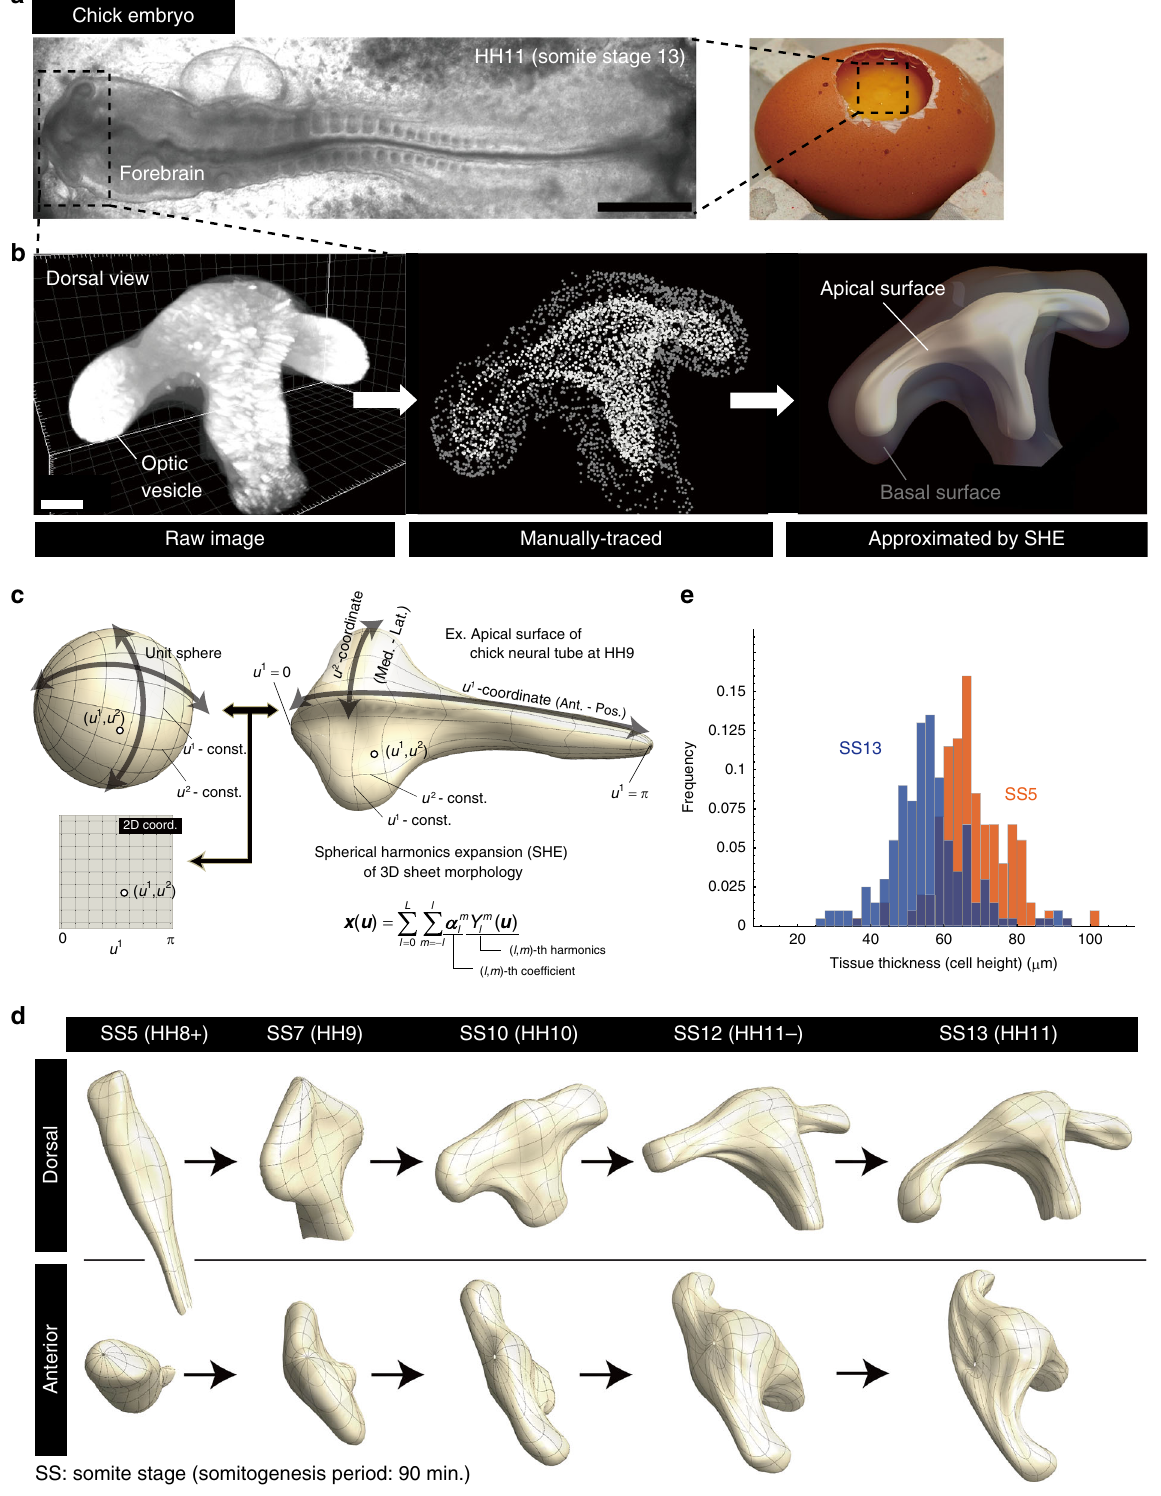
Fig. 1 Chick forebrain formation as an example of 3D epithelial sheet morphogenesis. a Chick embryo at HH11 (SS13). Scale bar: 500 μ m. b Methods for modeling forebrain 3D morphology. Using a two-photon microscopic image ( left ), apical and basal surfaces were manually traced. The traced data were represented as a set of dots for each surface. From the traced data, smooth 3D morphologies of both the apical ( white ) and basal ( gray ) surfaces were obtained using the spherical harmonics approximation ( right ). During the developmental stages studied, the forebrain has a single-layered structure. Scale bar: 100 μ m. c Spherical harmonics expansion (SHE) of 3D sheet morphology. This expansion not only provides a smooth approximation of complex sheet morphology but also a 2D coordinate system on the sheet. Since epithelial tissues often have sac-like or tubular morphologies that can be approximated by closed surfaces, SHE is a convenient way to de fi ne the 2D curvilinear coordinates on the surface (see also Fig. 2 and Supplementary Notes). d Time course of the morphological changes of the apical surfaces of the forebrain from SS5 (HH8+) to SS13 (HH11). e Distribution of tissue thickness. From SS5 to SS13, the thickness is almost spatially uniform although the mean values gradually decrease (see Supplementary Fig. 7 for